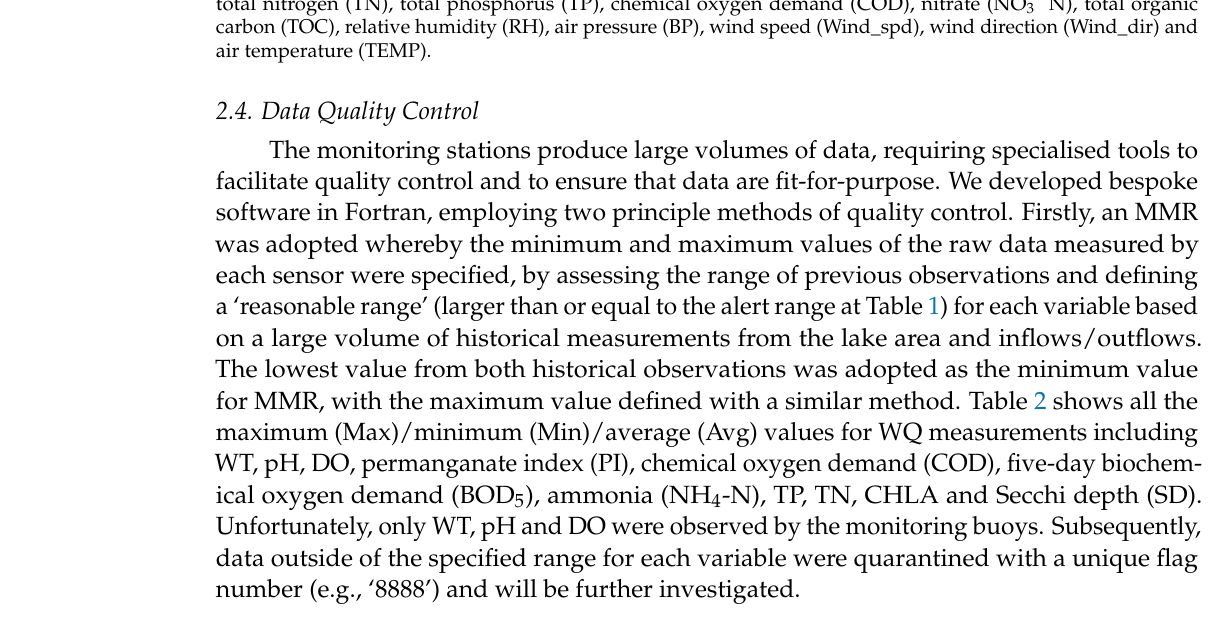
Table 2. Statistical value of measured water quality parameters at the four sites of Lake Qiandao from April 2001 to May